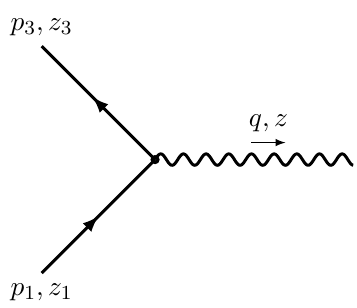
Figure 4 . The three-point interaction between two elementary particles with spin J and a